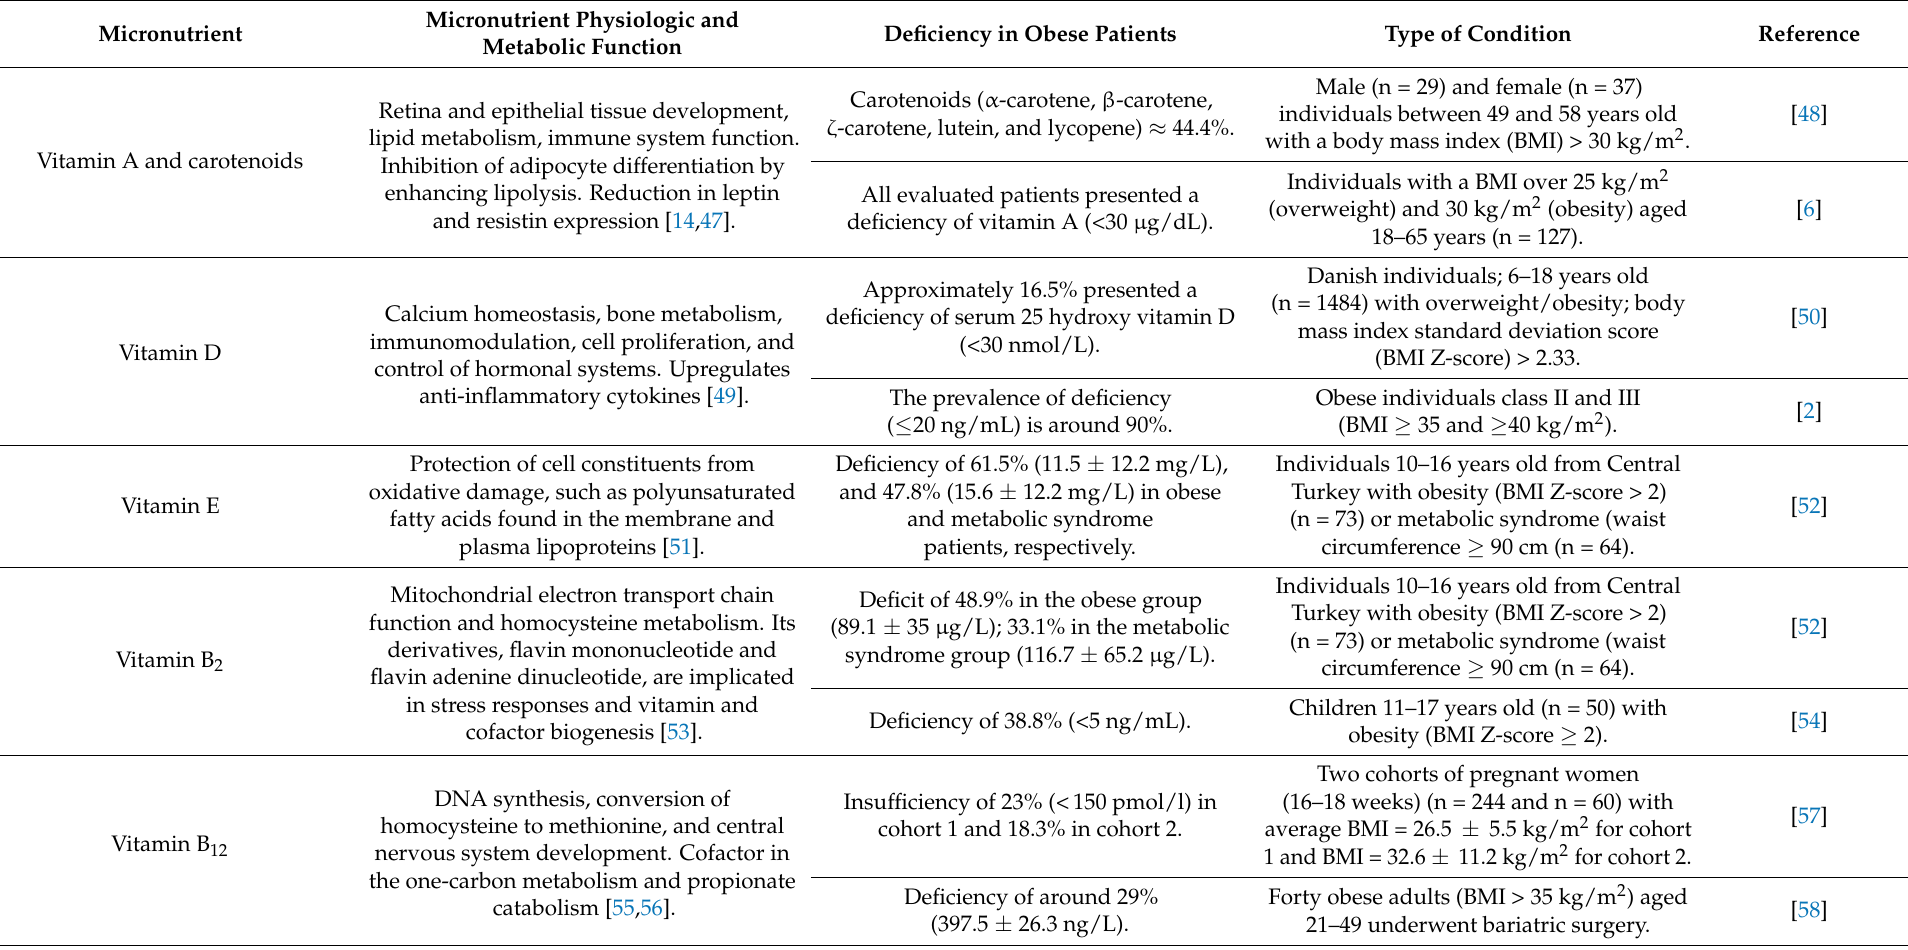
Table 1. Micronutrient deficiencies found in obese